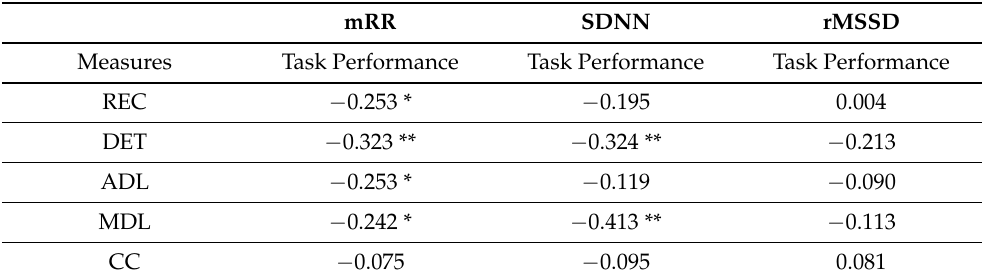
Table 1. Correlations between synchrony measures and task